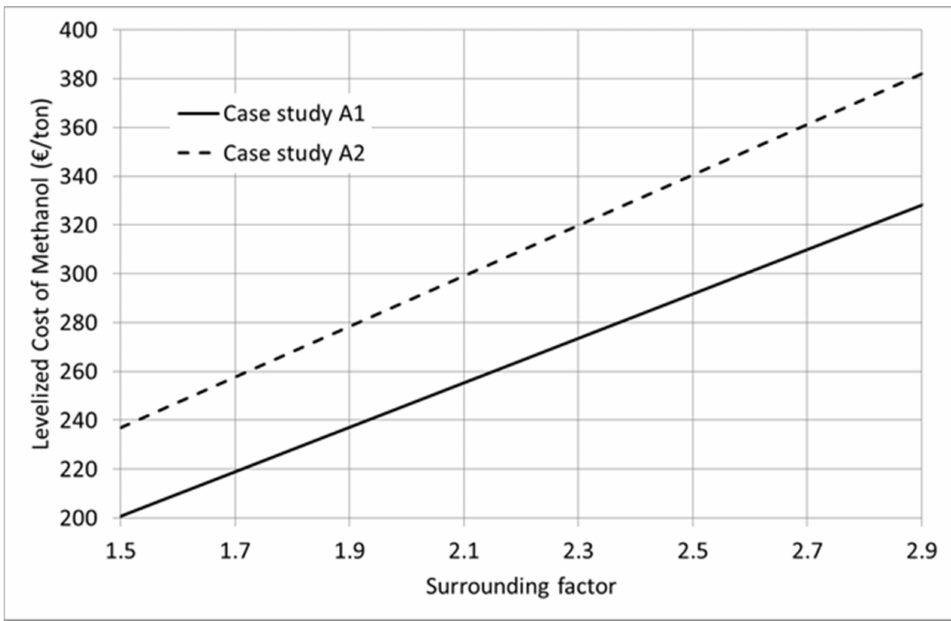
Figure 4. Influence of the surrounding factor on the levelized cost of methanol for case studies A1 and